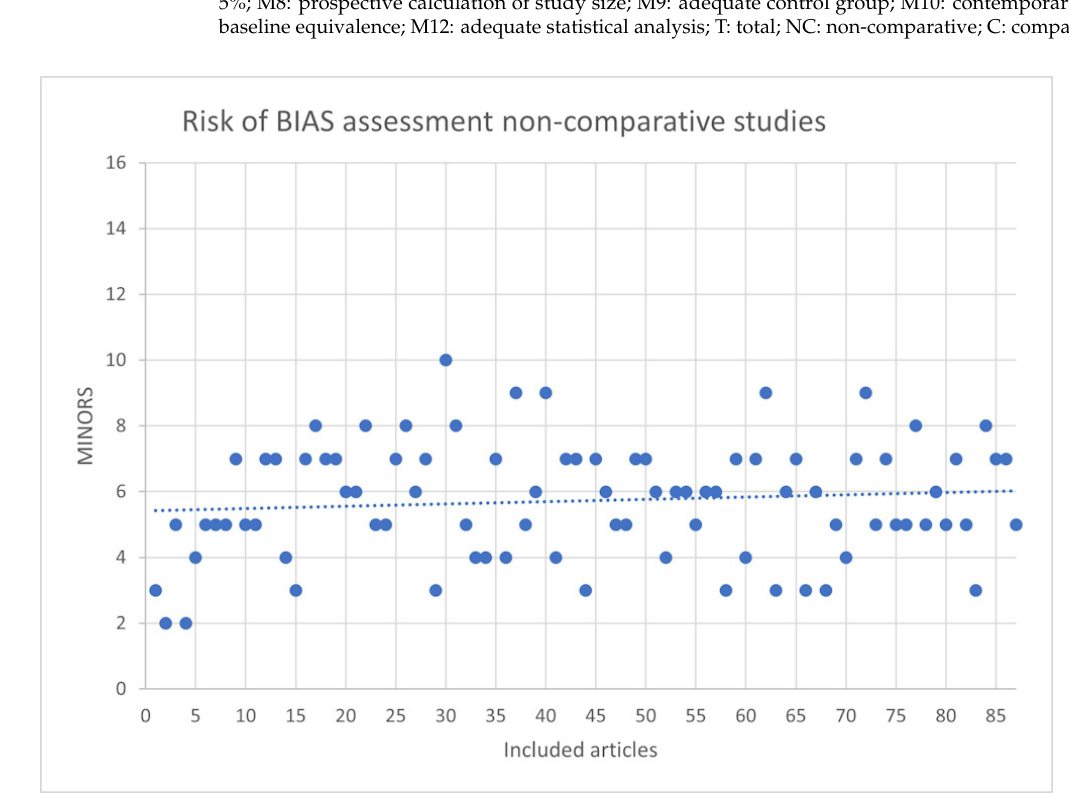
Figure 2. Risk of bias assessment for non-comparative studies. Risk of bias assessment of the 90 non-comparative studies according to the MINORS tool.